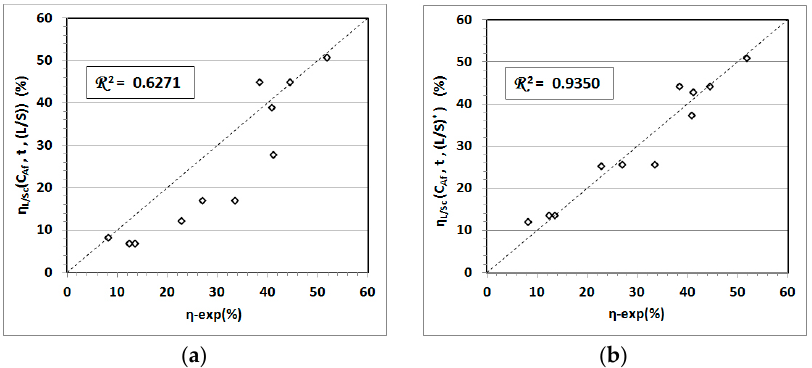
Figure 6. ( a ) Comparison between experimental values for Sc yield and respective theoretical predictions of Equation (4), for τ = 60 min, C Sc/BR = 97 g/t and data collection from experiments with and without leachate recycling; ( b ) Comparison between the experimental data of (a) and the respective theoretical predictions of generalized Equation (5). The optimized deviation correction terms are: C 0 = 1.65M, p = − 0.315, and Δ η = − 7.67%.